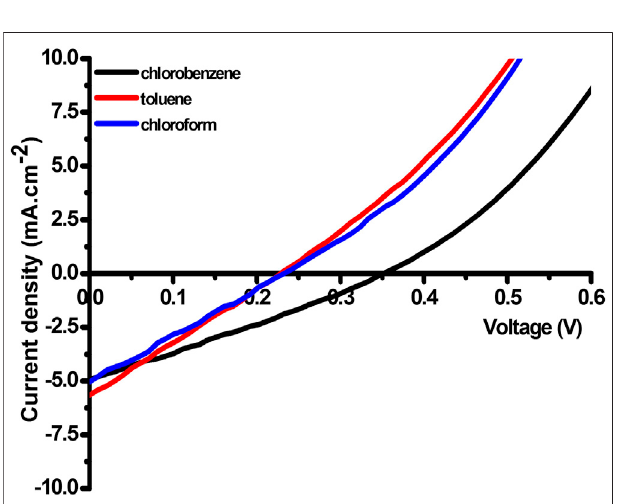
FIGURE 11 | J – V characteristics of the fabricated OPVs using HTB-co- P3HT as donor material in different